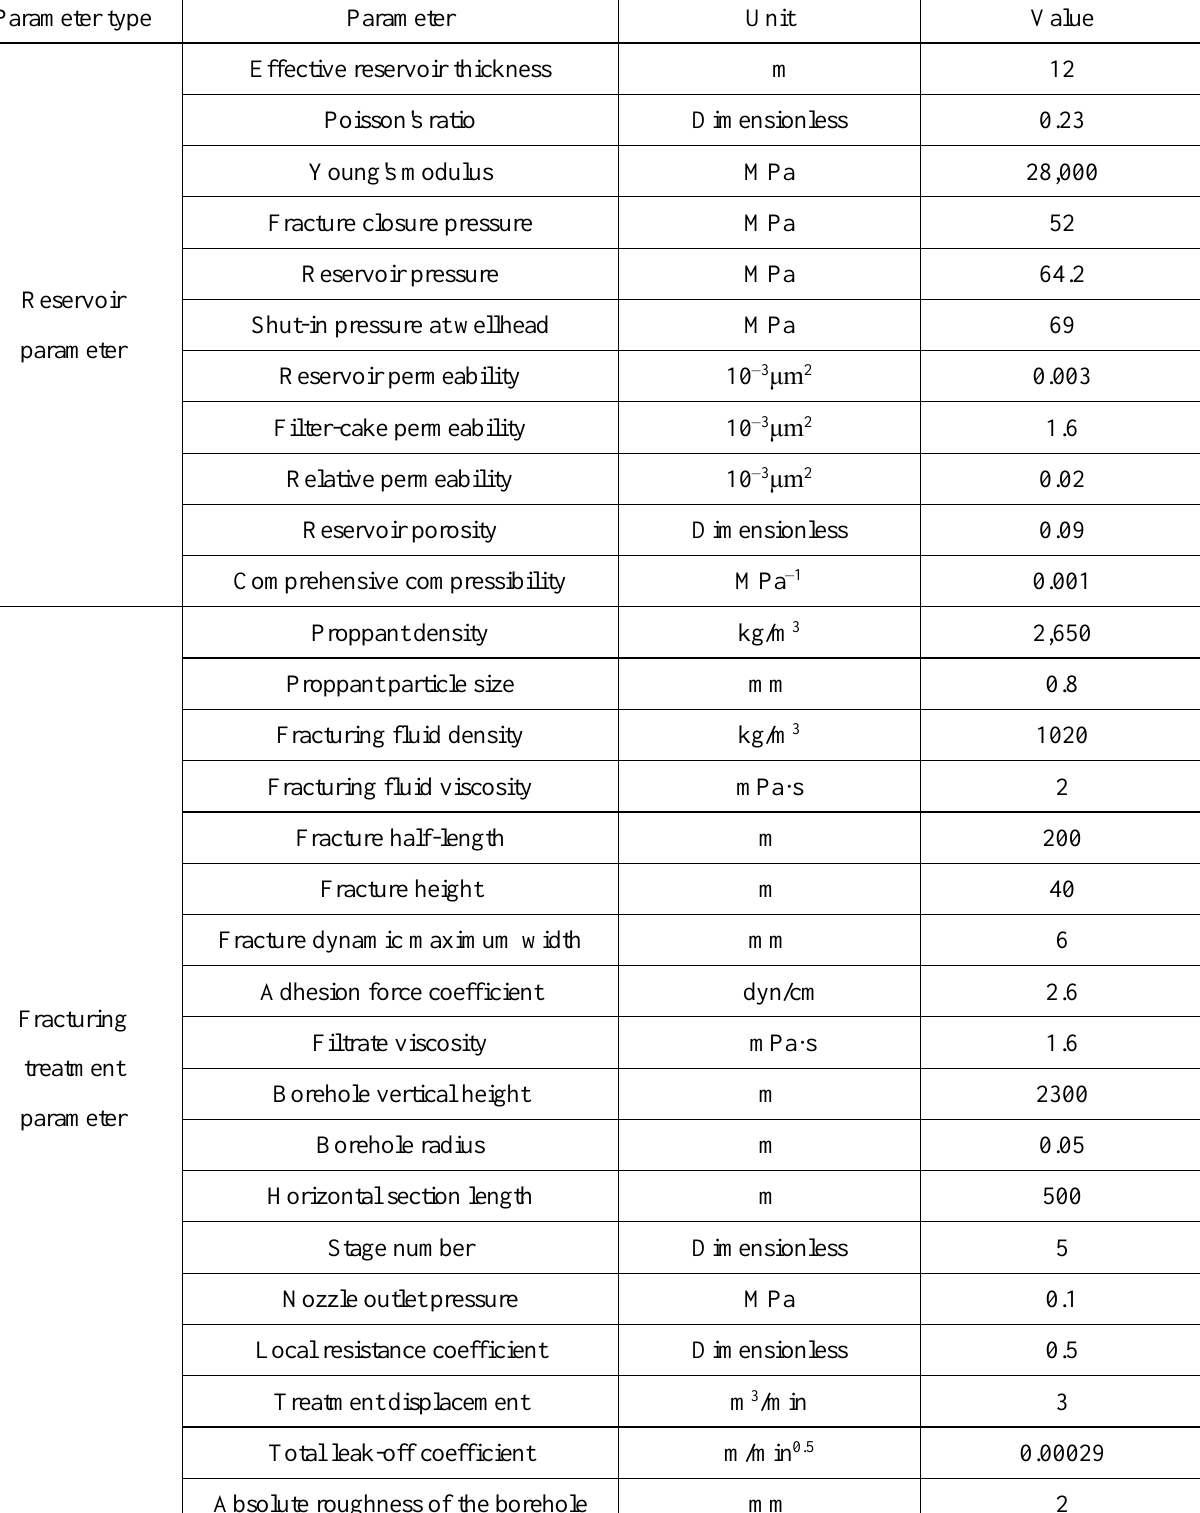
Table 1—Reservoir and fracturing treatment parameters of a shale gas well (Well A) in